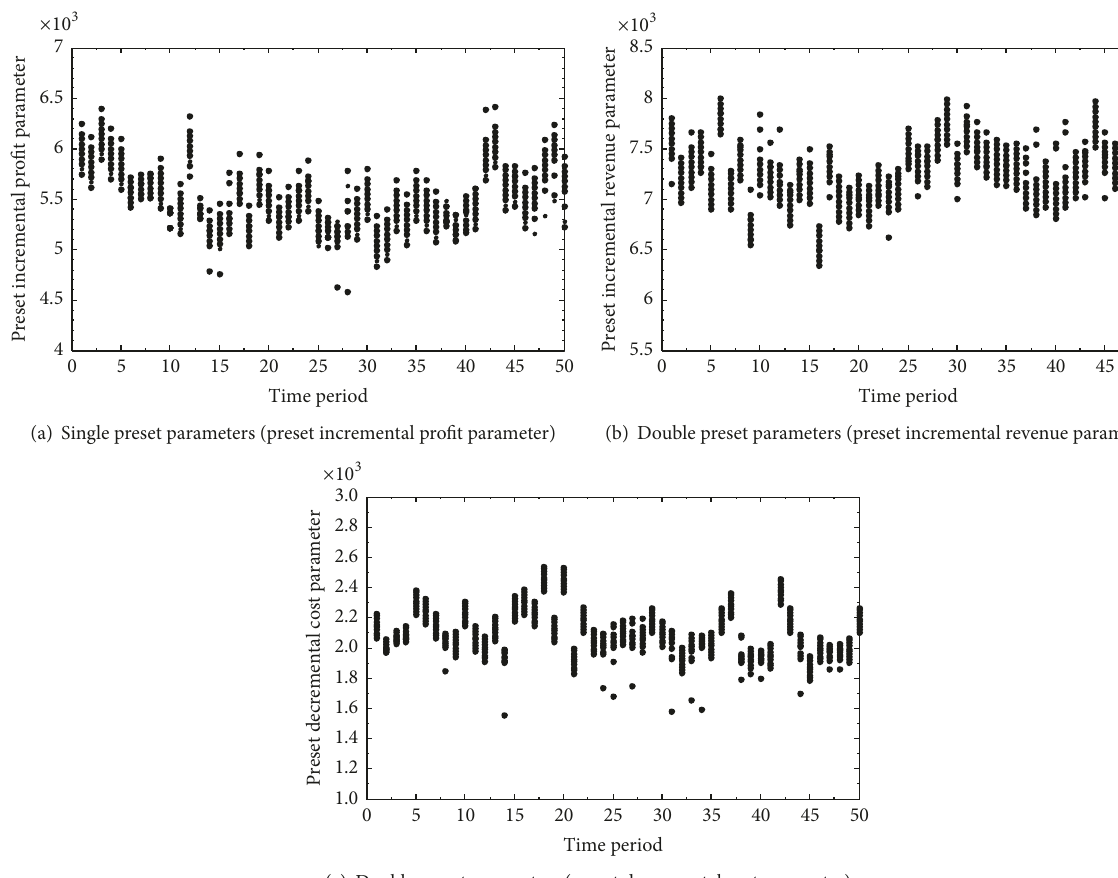
(c) Double preset parameters (preset decremental cost parameter) Figure 4: Dynamic change of preset increment parameters.